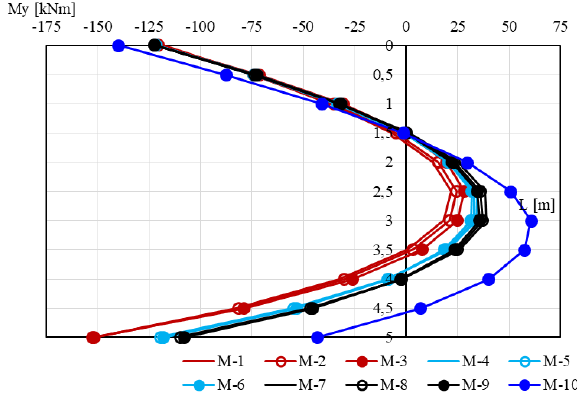
Figure 9: Distribution of bending moments in bridge’s left abutment